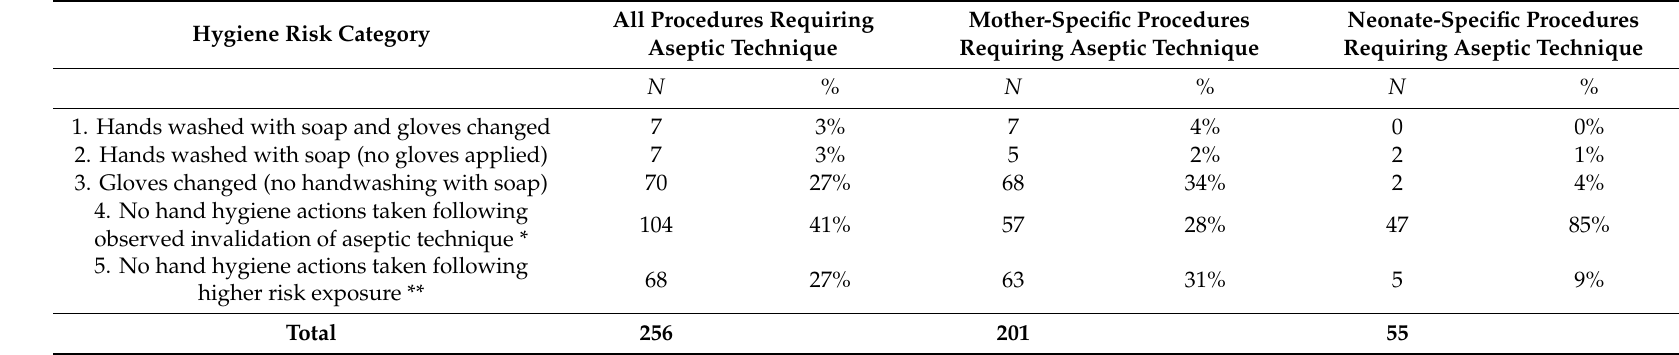
Table 3. Hygiene risk category during all procedures requiring aseptic technique, including: vaginal examinations, insertion of urine catheter or IV cannula, artificial rupture of the membranes, manual removal of placenta or blood clots, and suturing of the